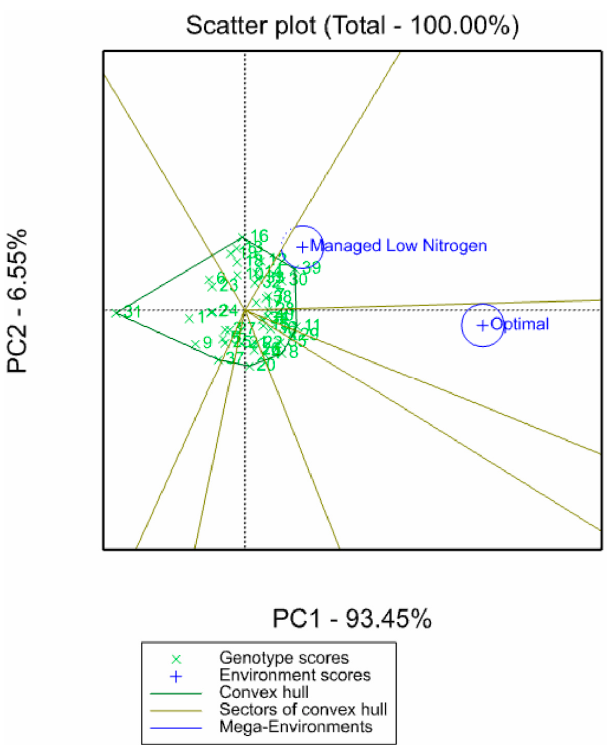
Figure 2. Biplot of the average environment coordination (AEC) view showing the diallel cross genotypes (1–36) and checks (37–40) specifically adapted to low-nitrogen and optimally managed sites in Zimbabwe and Zambia.